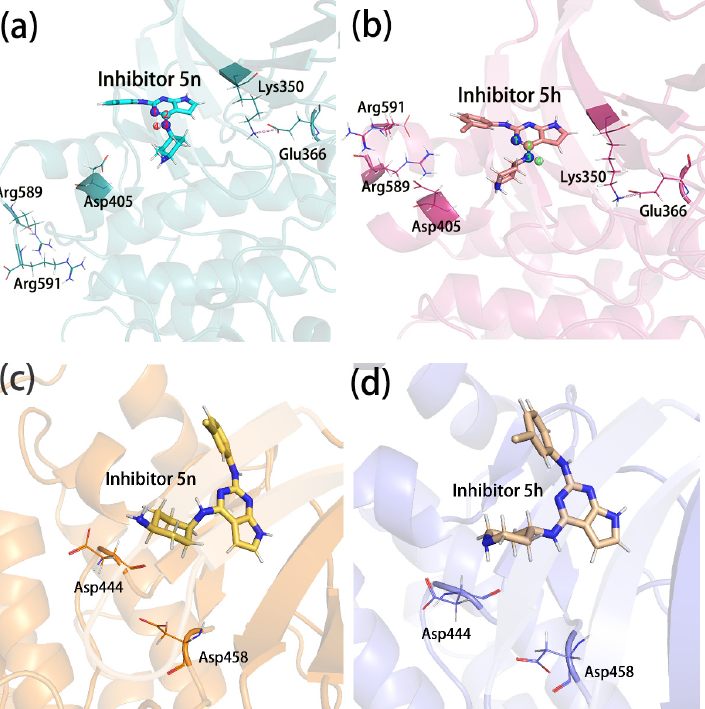
Figure 10. ( a – d ) The relationships of the charged residues to the 4-substituent position of the inhibitors. The salt bridges formed by Lys350 and Glu366 in ( a , b ) are shown as pink dashed lines, and the four atoms forming the dihedral angles are shown as balls and sticks and marked as 1, 2, 3, and 4, respectively.